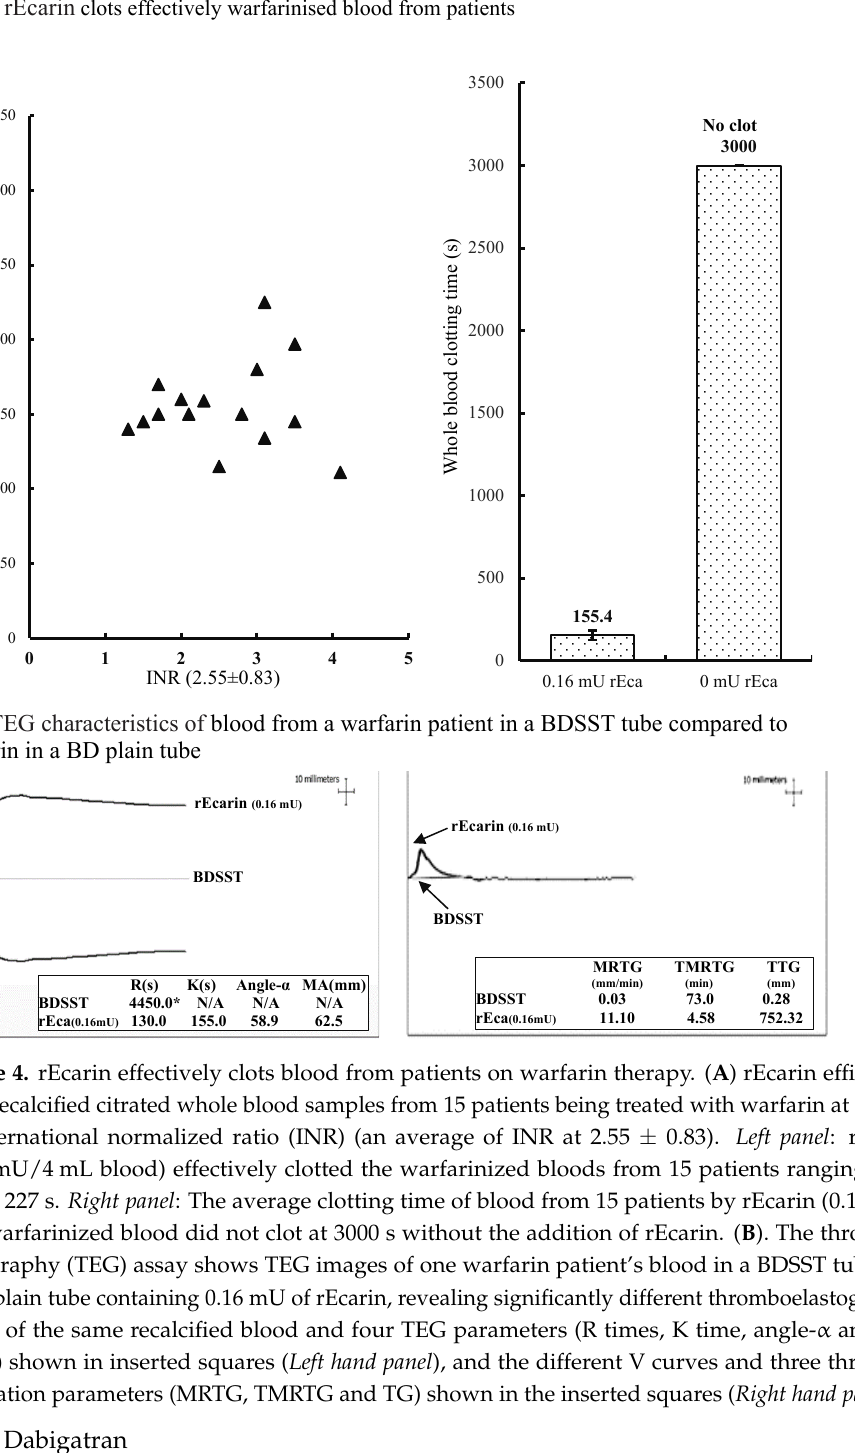
Figure 4. rEcarin clots effectively blood from patients on warfarin therapy 758